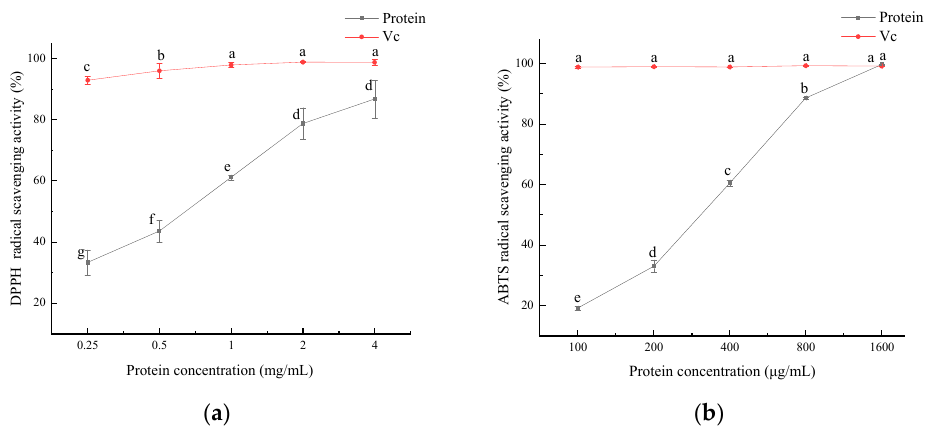
Figure 10. Antioxidant activity of SEP protein. ( a ) Effect of SEP on DPPH radical scavenging; ( b ) Effect of SEP on ABTS radical scavenging. Notes: means with different lower-case letter differed significantly at p <